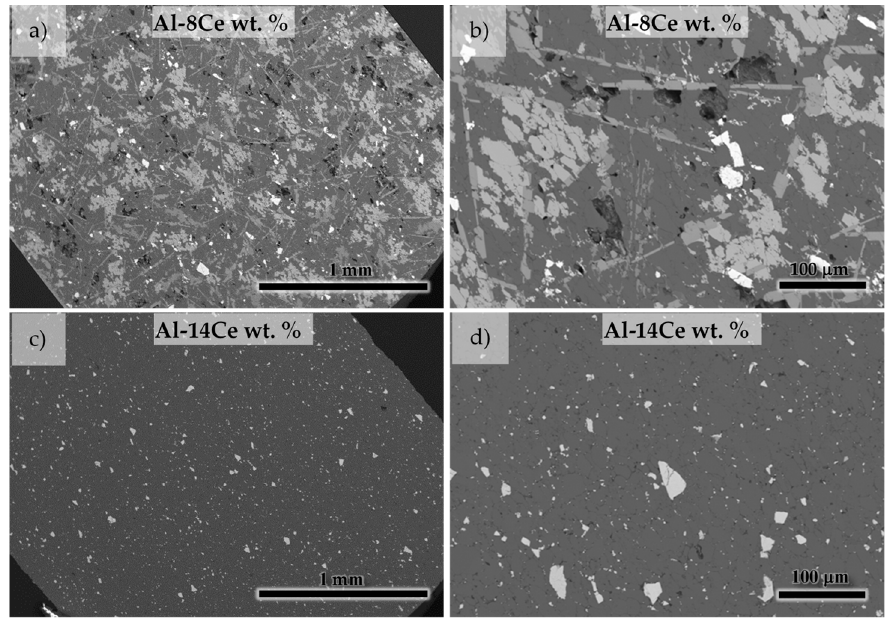
Figure 2. SEM microstructure of PIT ( a , b ) Al-8Ce wt % and ( c , d ) Al-14Ce wt %.